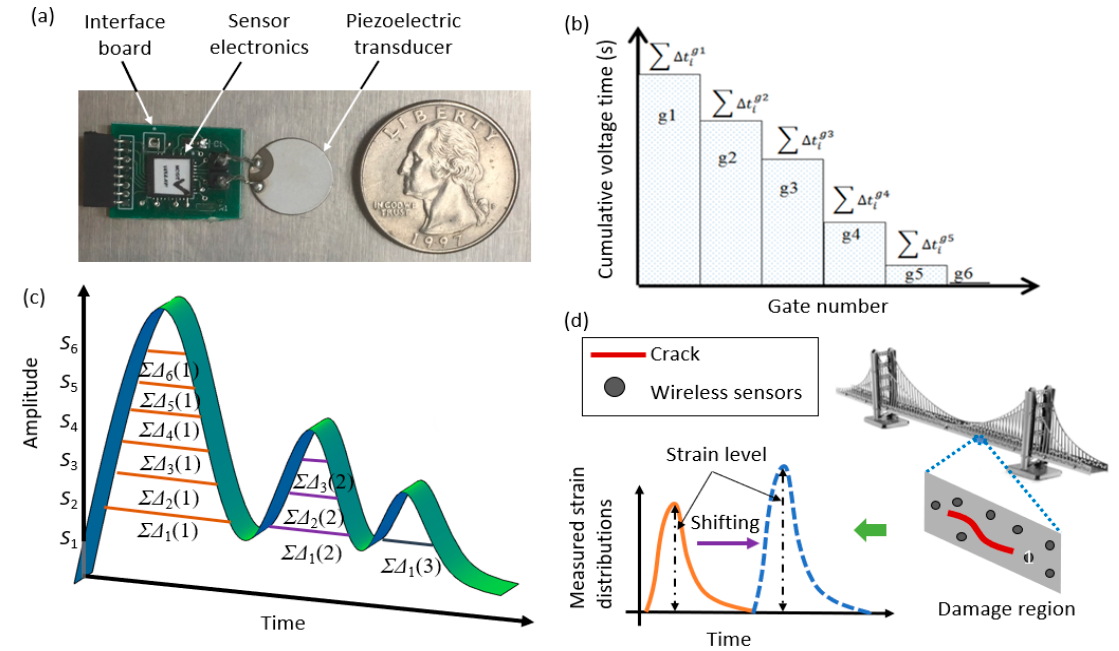
Figure 5. ( a ) Components of a piezoelectric-floating-gate (PFG) sensor, ( b , c ) Multi-level counting of cumulative times based on the strain values, and ( d ) Shift in probability density functions (PDFs) as damage progresses in a bridge [72].